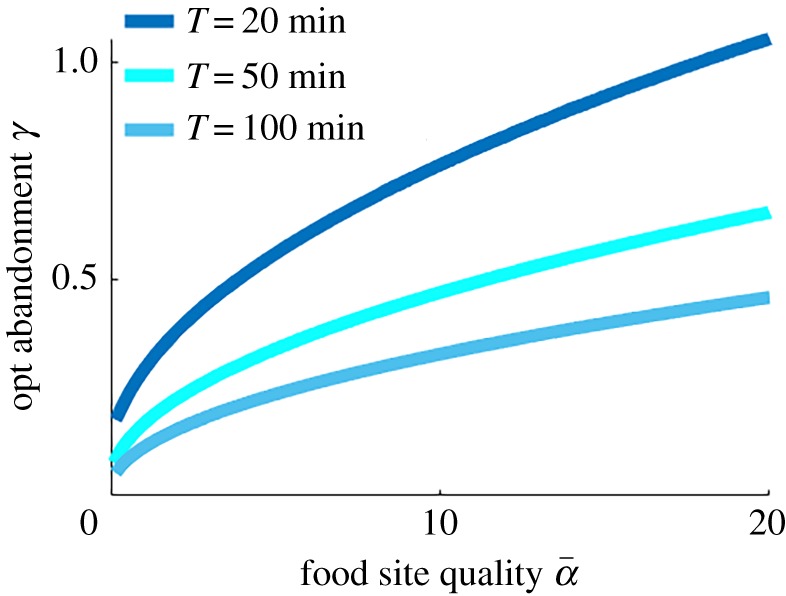
Reward rate, equation (2.4), maximizing values of abandonment (γ) parameter for a given food quality (α) and switching period (T) in the single-feeder model. Colony can maximize the reward J by calibrating the level of abandonment with the switching rate and feeder quality, discounting faster as the environment changes more quickly.